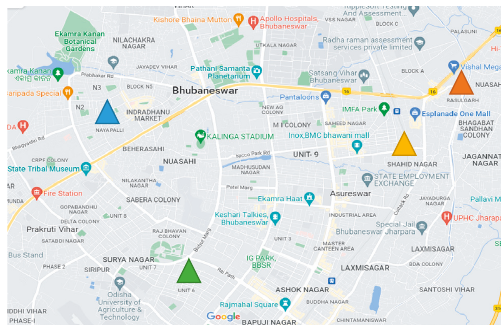
Figure 2: Google map showing different areas or zones of Bhu- baneswar (latitude: 20.296059 and longitude: 85.824539) where the noise data is considered [6]. Blue triangle: Nayapalli area, resi- dential zone; green triangle: Capital Hospital area, silence zone; yellow triangle: Shahid Nagar area, commercial zone; orange tri- angle: Rasulgarh area, industrial